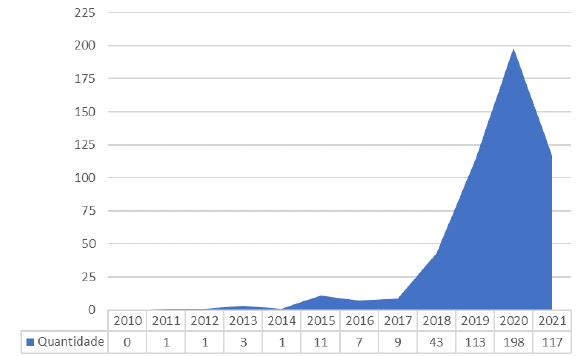
Figure 2. Evolution over the years of the number of publications of algo- rithms for fake news identification. Source: The authors. Accuracy greater than 90% was only achieved in 2019 by Lakshmanarao, Swathi, and Kiran (2019) (article